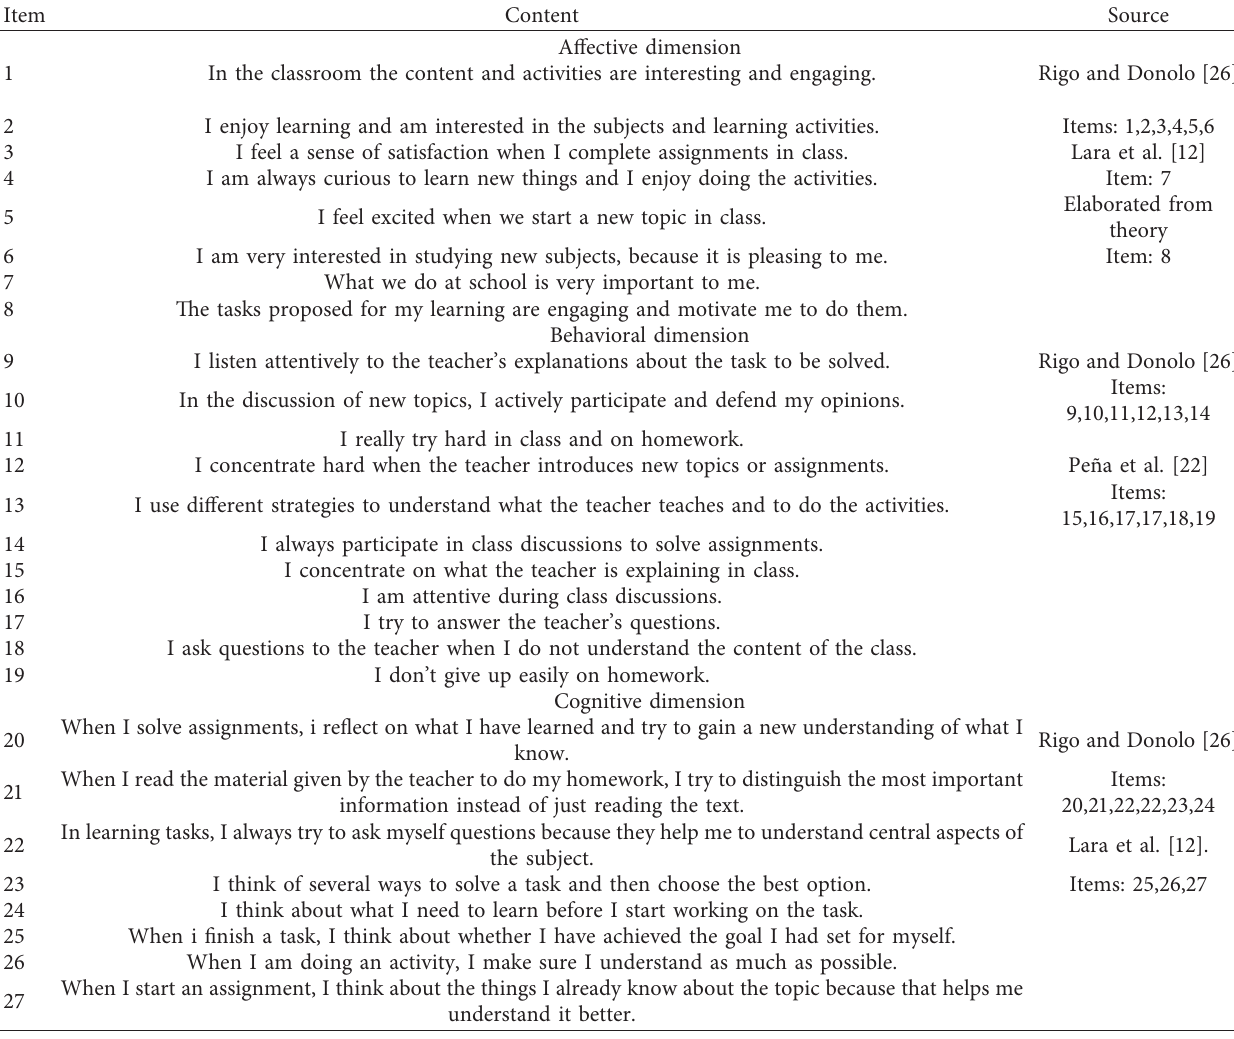
Table 1: Origin of items from the initial version of